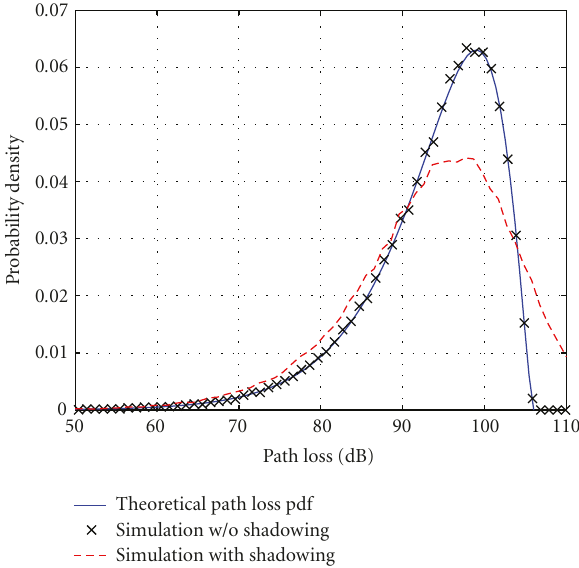
Figure 5: Path loss pdf between two randomly chosen nodes on a disk with radius R = 100 m, drawn from a uniform node distribution. The theoretical pdf is shown to agree with the pdf excluding log-normal shadowing obtained via